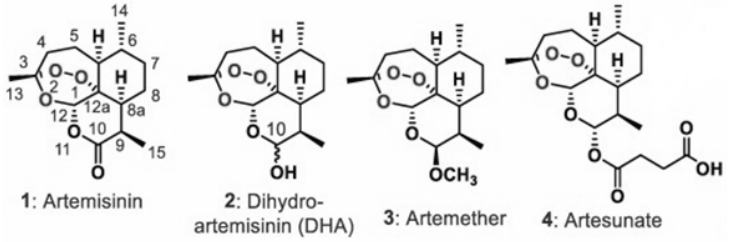
Figure 1. Artemisinin 1 and its derivatives, dihydroartemisinin (DHA) 2, artemether 3, and artesunate 4.